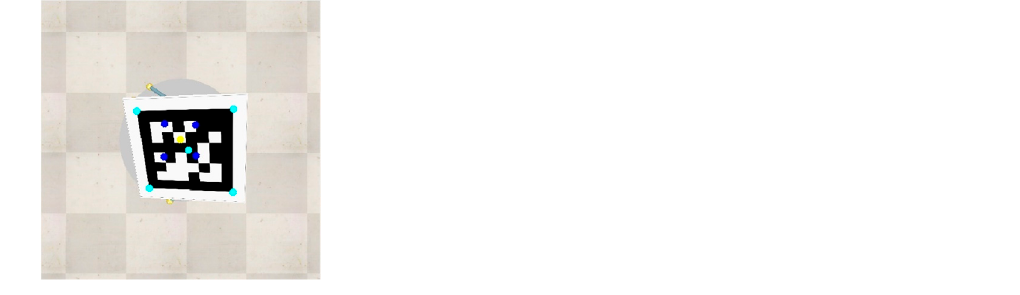
Figure 8. Touch points of the range sensor (blue), AprilTag center (cyan), AprilTag corners (cyan), and of the sensor unit principle point (yellow).